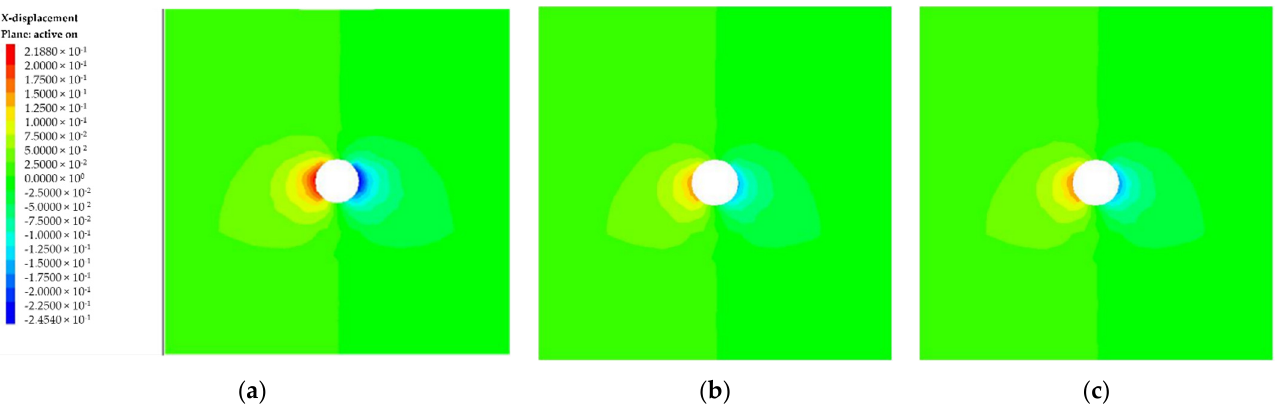
Figure 10. Horizontal displacement distributions of the surrounding rock of the support face: ( a ) unsupported, ( b ) radial support, and ( c ) non-radial support.